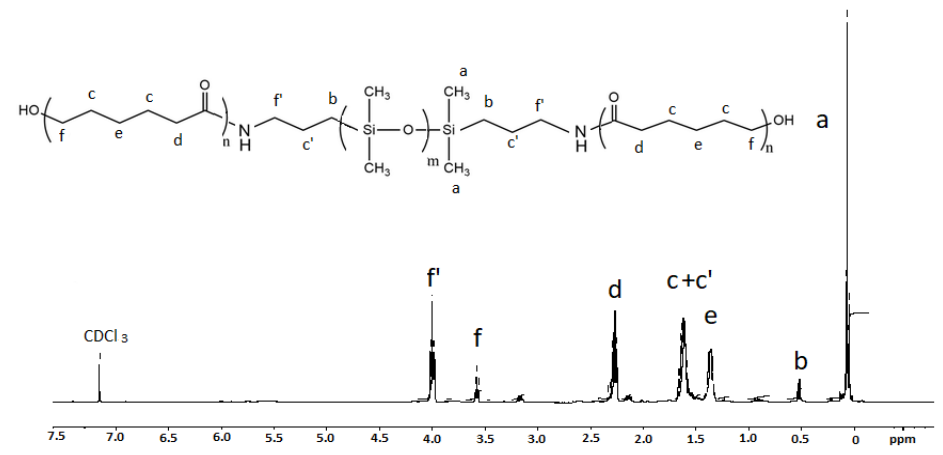
Figure 2. NMR spectrum for synthesized APDMS-CL.